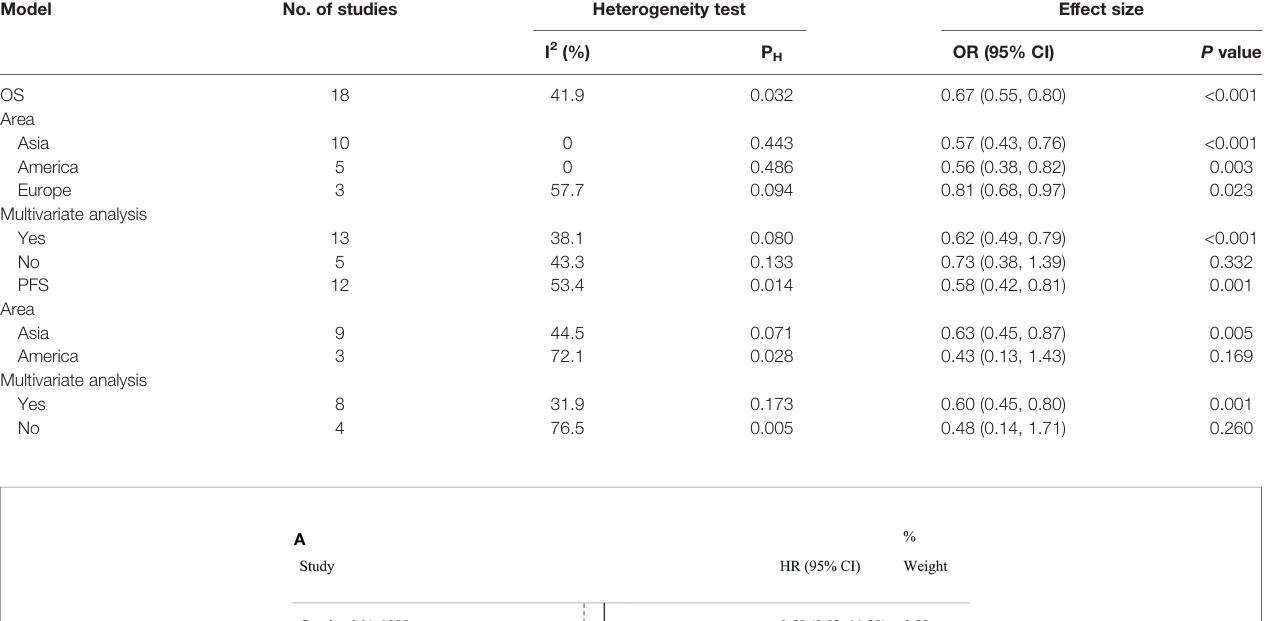
TABLE 3 | Outcomes of the subgroup analysis (total ovarian cancer patients).